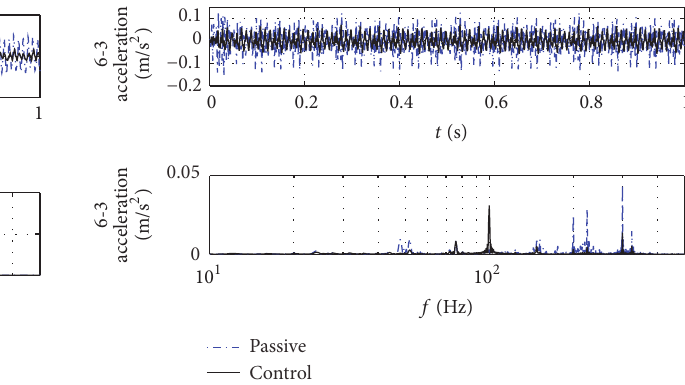
Figure 23: Comparison time-frequency domain curves of acceler- ation response of position 6-1 on the experimental platform before and after being controlled.